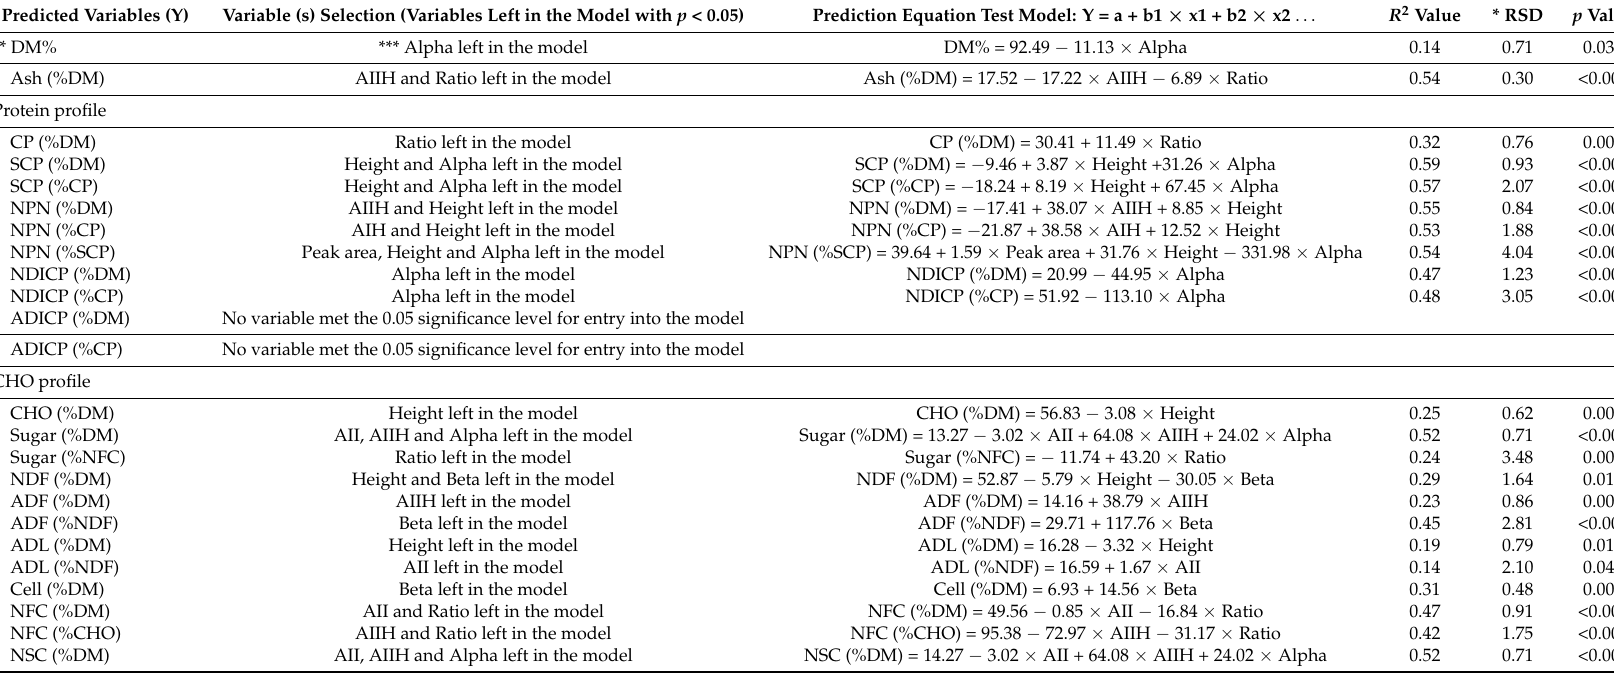
Table 12. Multiple regression analyses to find the important protein structural variables for predicting chemical profiles of canola meal. Predicted Variables (Y) Variable (s) Selection (Variables Left in the Model with p <